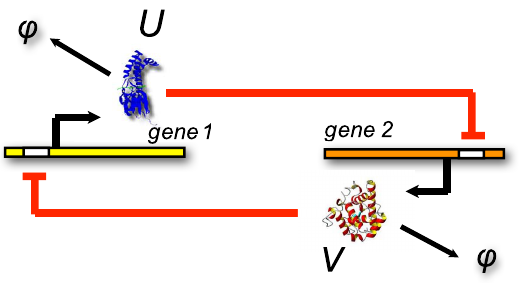
Table 2 . d independent birth-death processes: r eff ~ r eff p {